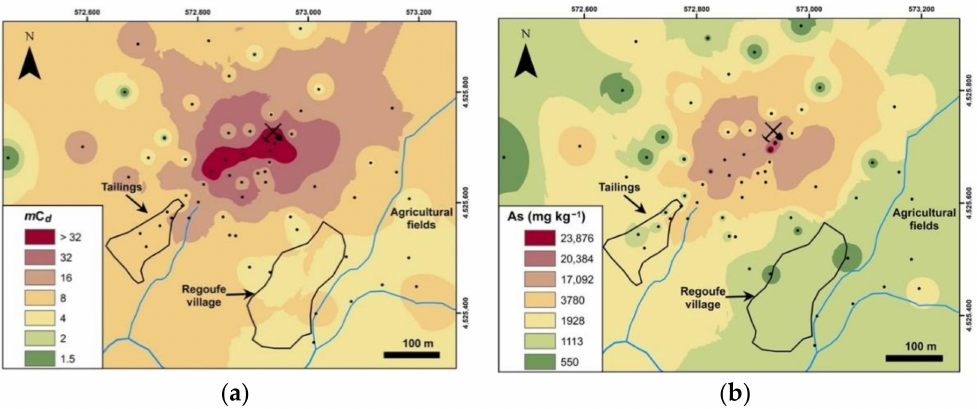
Figure 6. Spatial distribution maps of ( a ) the modified degree of contamination ( m C d ) and ( b ) the arsenic concentrations in topsoils of the studied